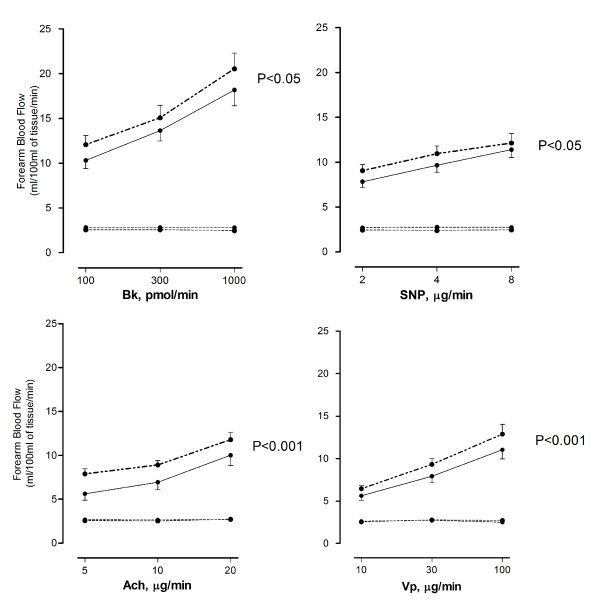
Forearm blood flow measured six hours after diesel exhaust (solid line) and filtered air (dashed line) exposure during unilateral intra-brachial infusion of bradykinin (Bk), acetylcholine (Ach), sodium nitroprusside (SNP) and verapamil (Vp) in infused and non-infused (dotted lines) arms. Effect of exposure compared with using 2-way ANOVA with repeated measures. Data plotted as mean ± SEM. P-values are given for diesel exhaust exposure vs. air.